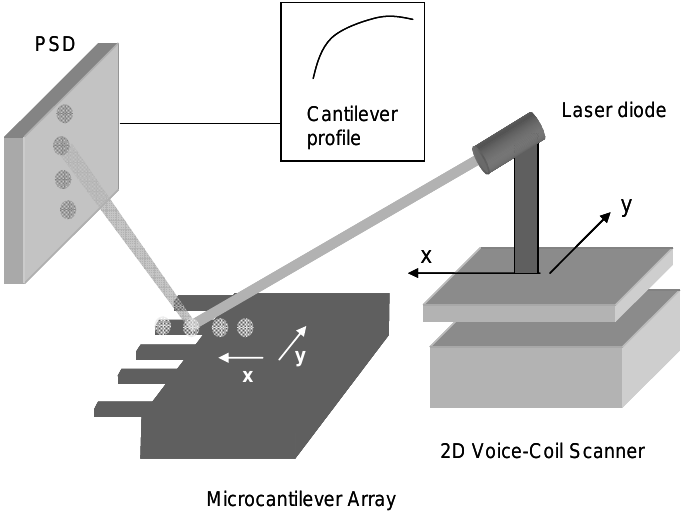
Figure 1. Schematic drawing of the set-up for the read-out of the cantilever profiles in arrays. The laser is mounted in a 2-D voice-coil scanner that allows obtaining the profile of an arbitrary number of cantilevers in the array. Measurements can also be performed in